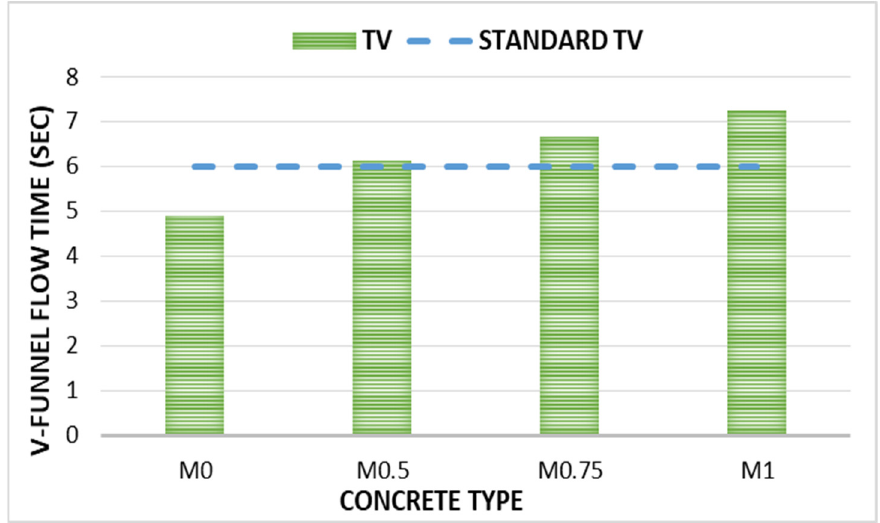
Figure 9. Increasing viscosity with the standard limit of different SCC mixes.